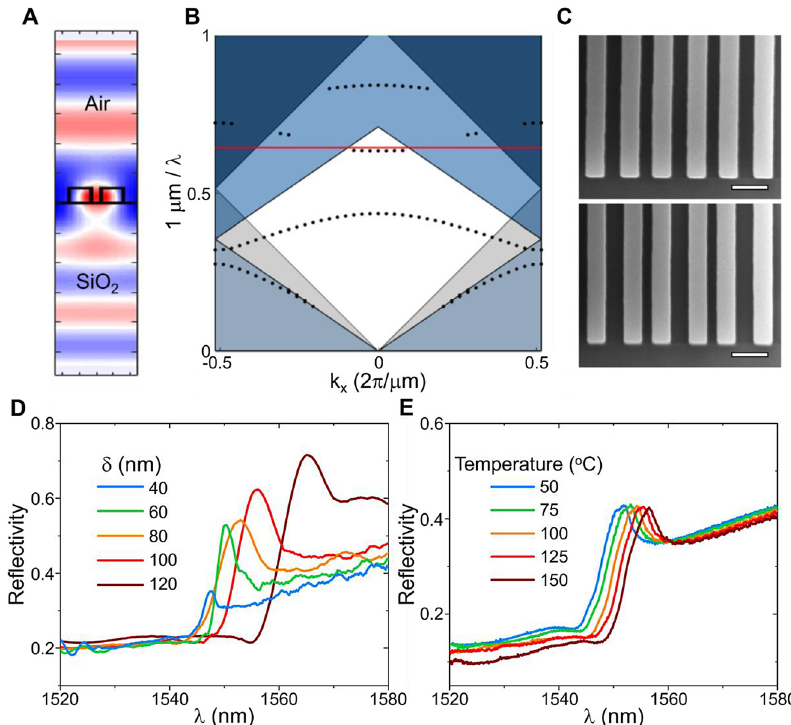
Figure 2: Design and experimental results of one-dimensional (1D) free-space metasur- face